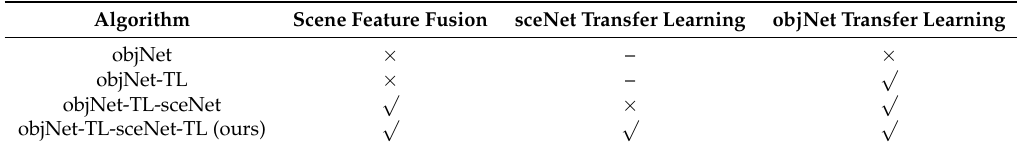
Table 7. List pf the configurations of each experiment.